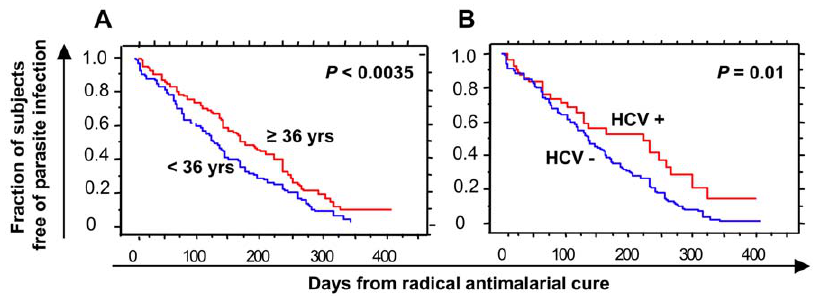
Figure 4. Kaplan-Meier Survival Curves for the Patients According to (A) Age or (B) Hepatitis C Virus serostatus. (A) in blue fraction of patients # 36 years old free of infection, in red patients $ 36 years old free of infection. (B) in blue fraction of patient HCV negatives free of infection, in red fraction of patient HCV positive free of infection.